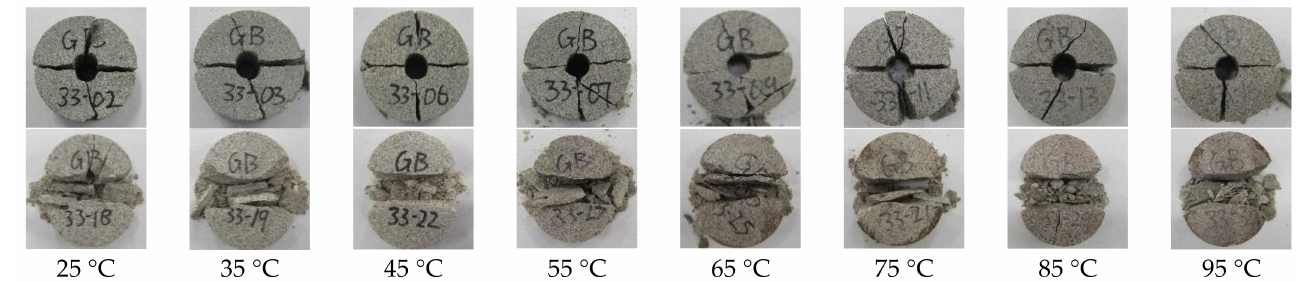
Figure 12. Fracture morphology of sandstone